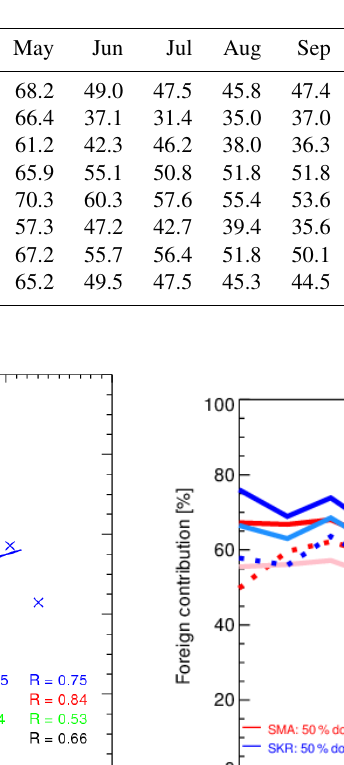
Table 7. Summary of foreign contributions (%) to surface PM concentrations over the SMA for each month. Seven sensitivity simulations from Table 1 (without duplicated runs) are listed.